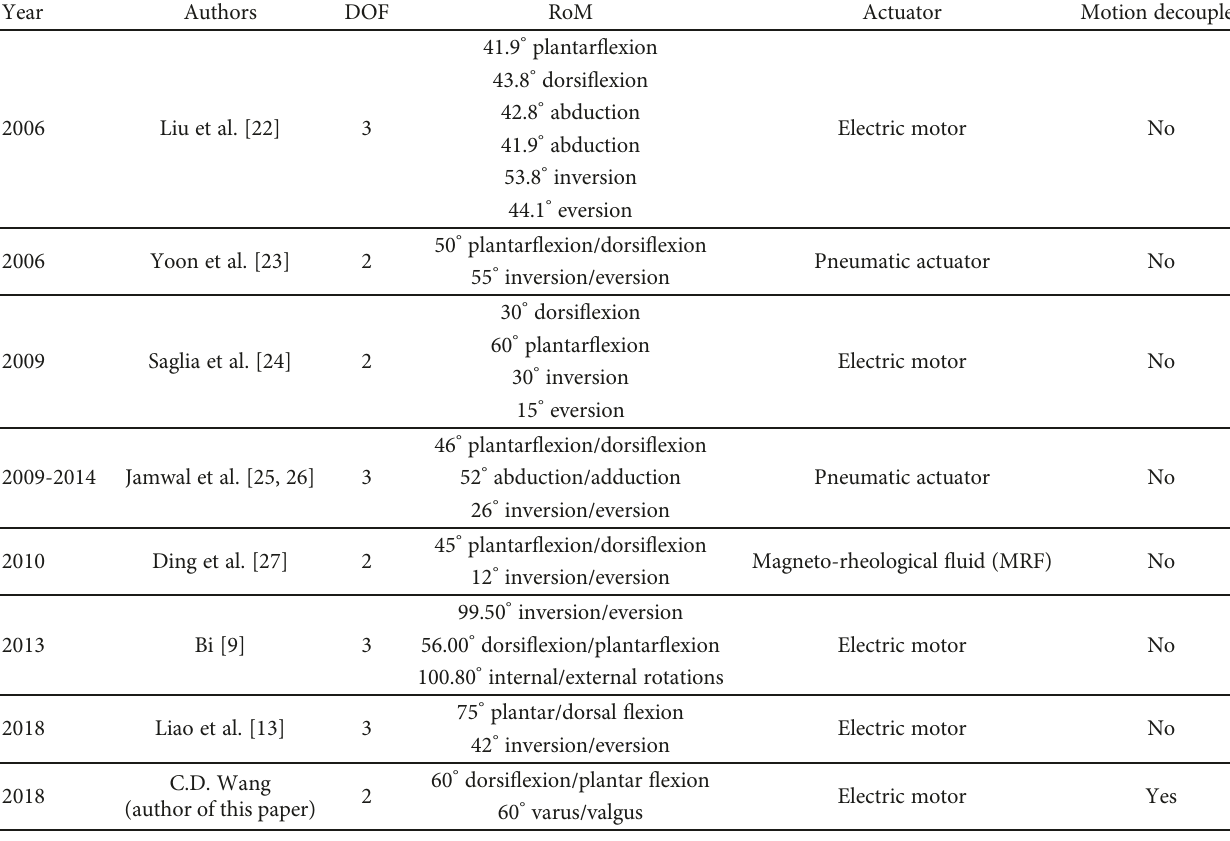
Table 1: Actuation, RoM and motion decoupled characteristic of ankle rehabilitation robots.